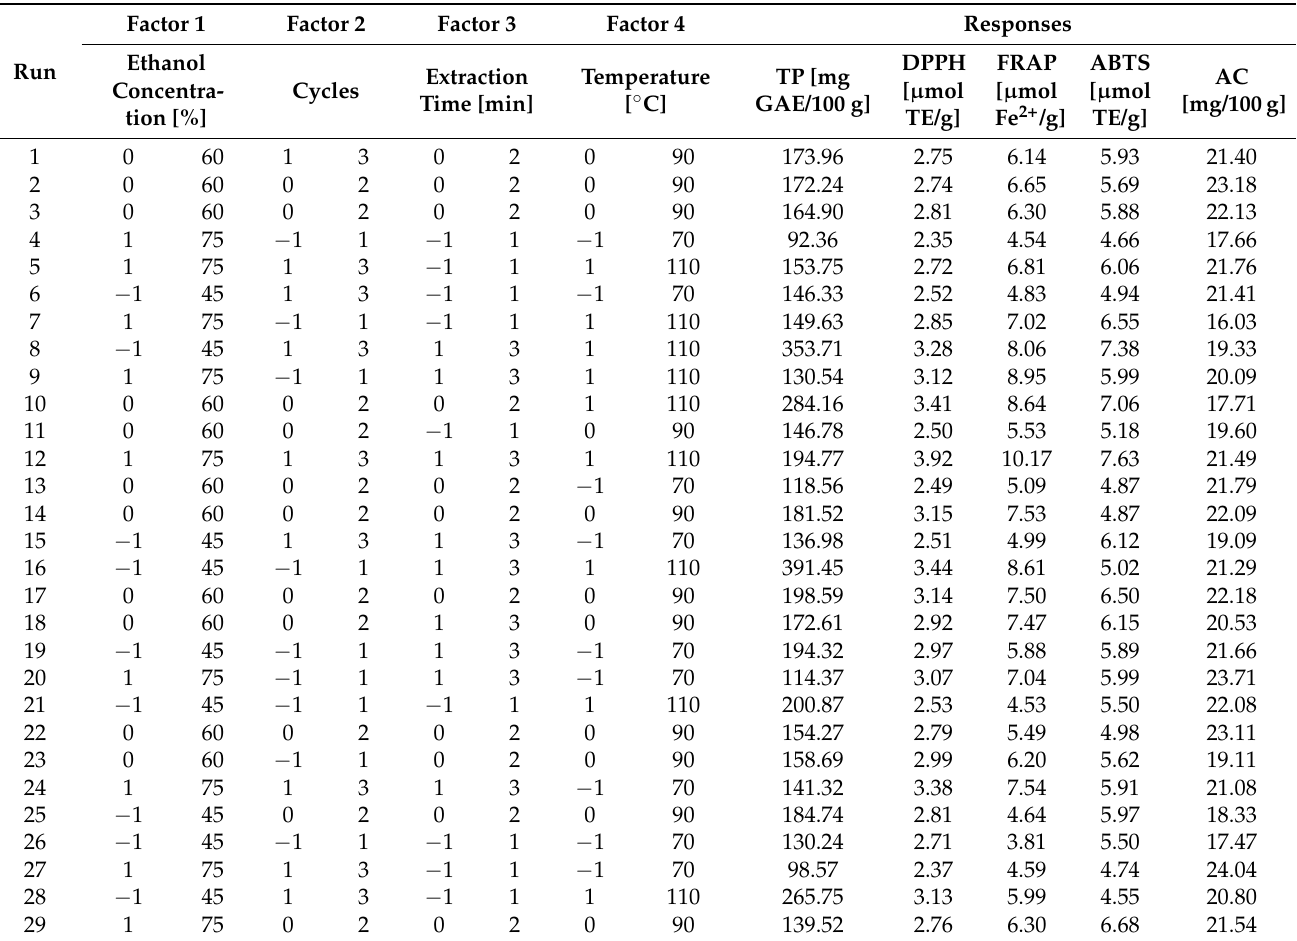
Table 1. Central composite experimental design with natural and coded values of independent variables and experimentally obtained values for investigated